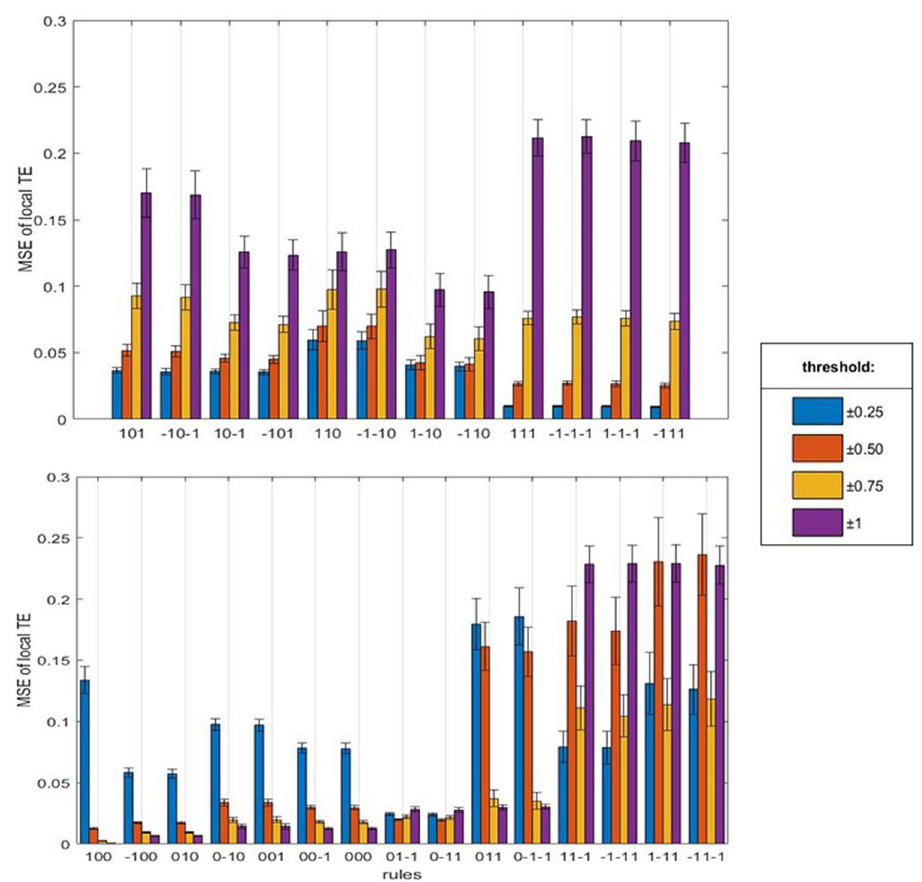
Figure 5. Mean Squared Error (MSE) of local TE as a function of signal thresholds. Top panel: rules with an increasing trend at increasing thresholds. Bottom panel: rules with mixed trend at increasing thresholds. For the meaning of columns and colours and the sequence of rules, see Fig.